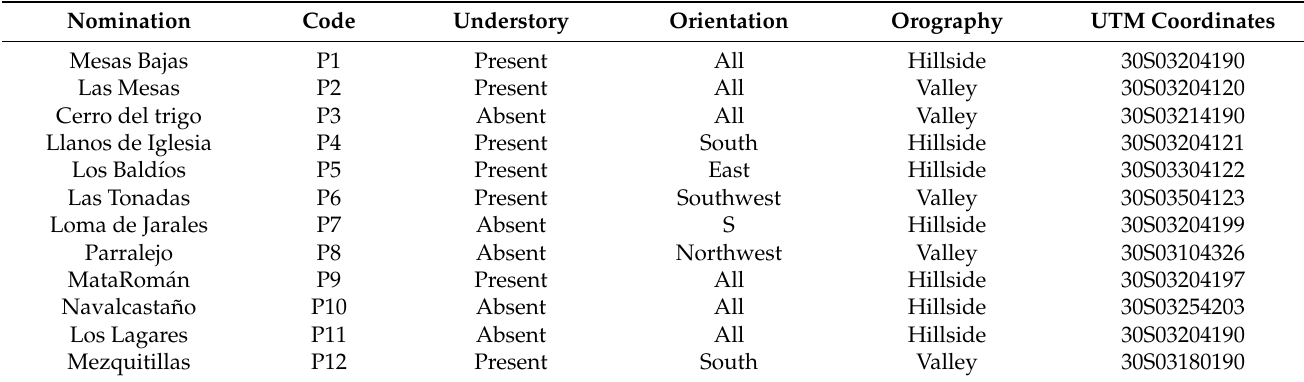
Table 1. Site name, code, environmental features (undergrowth, solar orientation, orography) and UTM (Universal Transverse Mercator) coordinates and for each of the sampling plots. “All”: orientation to all winds. Nomination